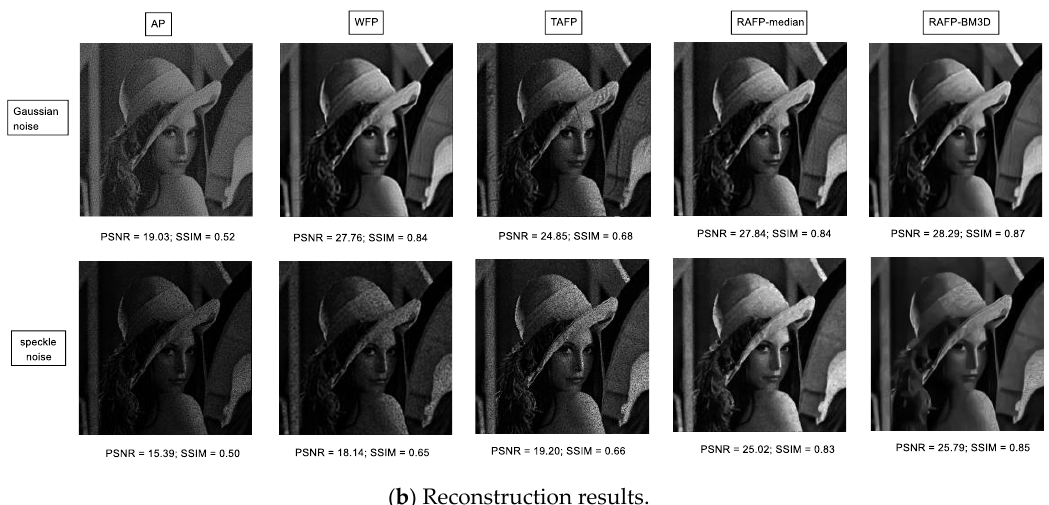
Figure 6. Visual comparison of the reconstruction results by different methods under Gaussian noise and speckle noise.